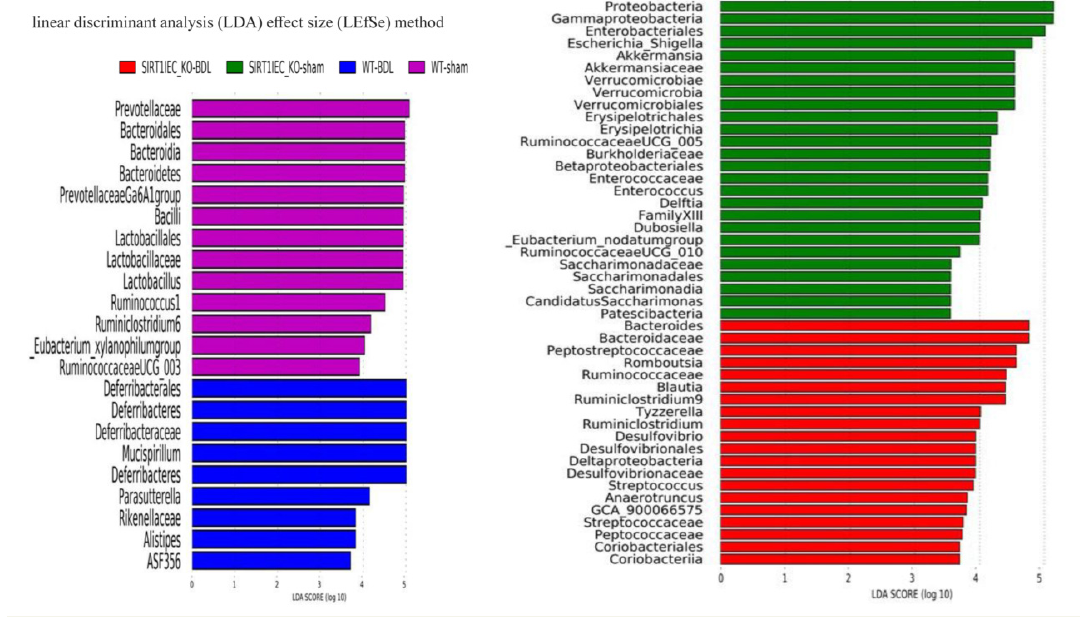
Figure 7. Intestinal SIRT1 deficiency aggravates cirrhosis-related intestinal bacterial dysbiosis. Overall distribution of statistical significance and biological relevance of intestinal bacteria among four groups [WT-BDL (blue), SIRT1 IEC KO -BDL group (red), WT-Scheme 1. SIRT1 IEC KO -sham (green)] that analysis by the linear discriminant analysis (LDA) effect size (LEfSe) method.